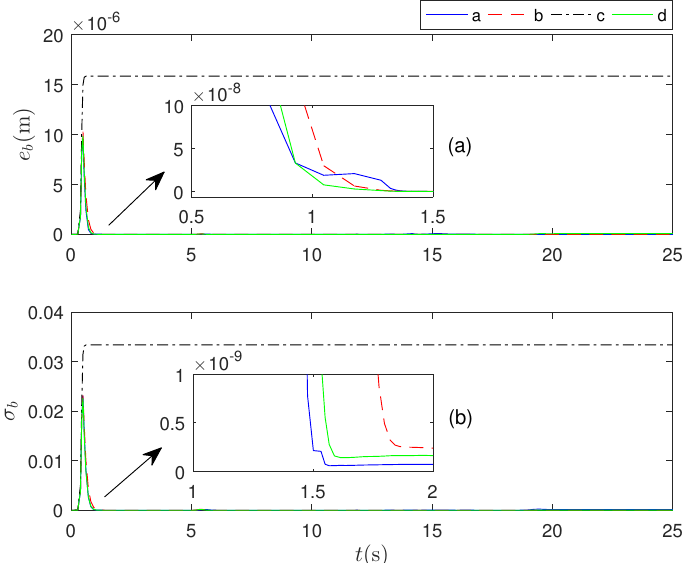
Figure 7. The pose errors of base in four methods (three axis